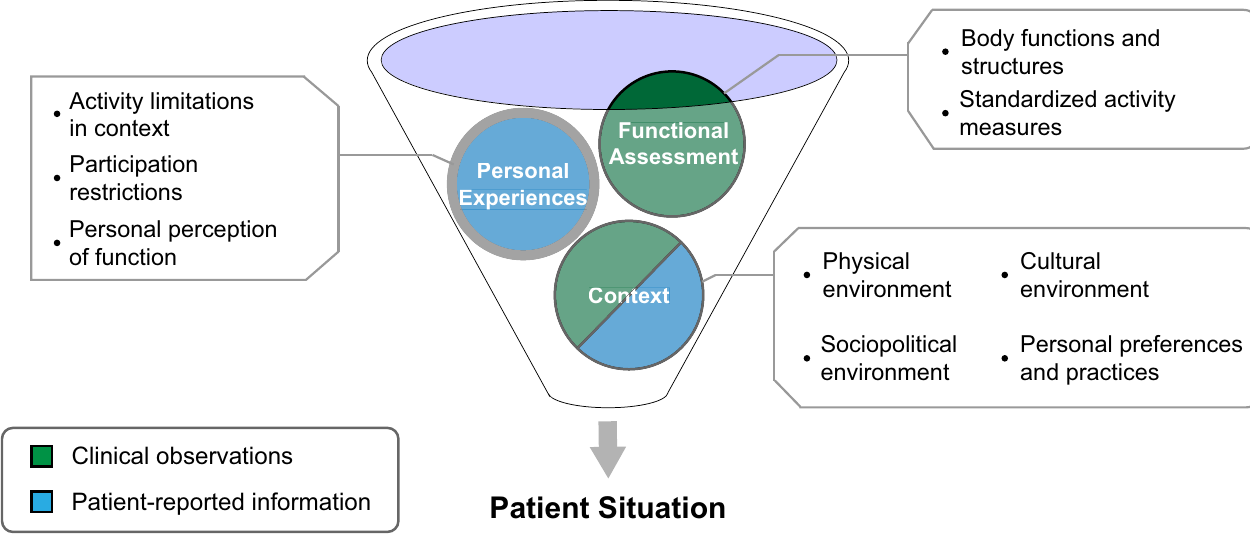
Fig 3. Conceptual illustration of the multiple dimensions of health data needed to fill in the picture of a patient’s functional situation. Capturing these data requires information both from clinical observations and patient-provided information. Without including all of functional assessments, the patient’s personal experiences, and their context, the overall picture of the patient’s situation is incomplete.